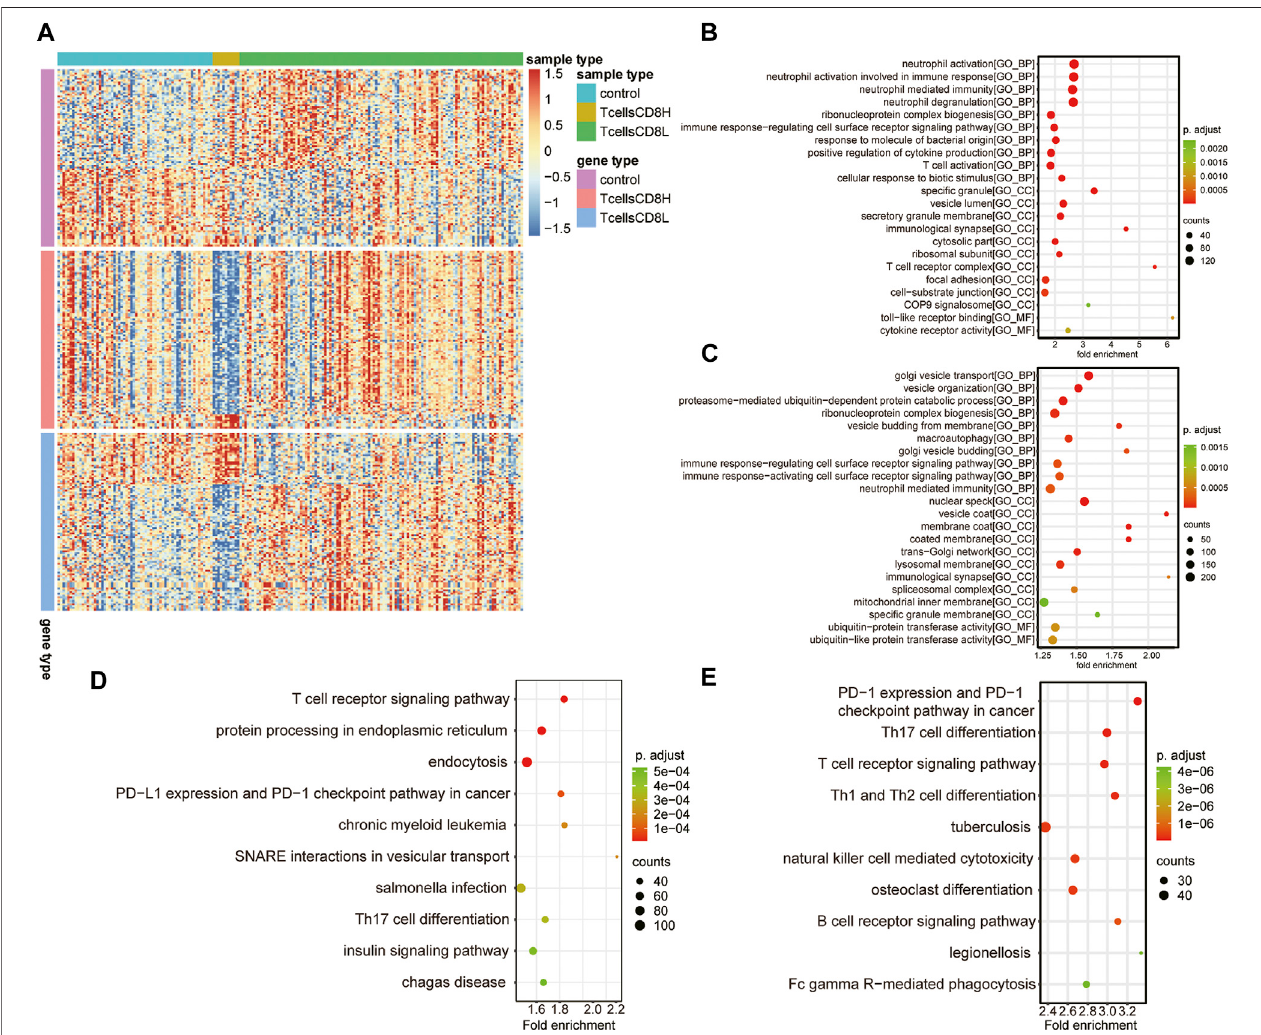
FIGURE4| PotentialfunctionsofmarkergenesintheTcellCD8HclusterandTcellCD8Lcluster. (A) Theexpressionheatmapofthetop100markergenes(sorted according to |log 2 Fold change|) for the normal group, T cells CD8H cluster, and T cells CD8L cluster. Red indicates relative upregulation of gene expression; blue indicates the relative downregulation of gene expression; light yellow indicates no signi fi cant change in gene expression. (B,C) The dotplot of the GO enriched BP, MF, and CC terms in marker genes of the T cell CD8L (B) and T cell CD8H (C) clusters. (D,E) Signi fi cant KEGG pathways of marker genes in the T cell CD8H (D) and T cell CD8L (E) clusters. The larger the circle, the more genes it contained; conversely, the smaller the circle, the fewer genes it contained. The color of the circle is correlated with the p Value. The lower the p Value is, the closer it is to the red value. The higher the p Value is, the closer it is to the green value. GO, Gene Ontology; BP, biologicalprocess;CC,cellularcomponent;MF,molecularfunction;KEGG,KyotoEncyclopediaofGenesandGenomes.Control:healthydonors( n =64).TcellCD8H:a high proportion of CD8 + T cells ( n = 12). T cell CD8L: a low proportion of CD8 + T cells ( n =